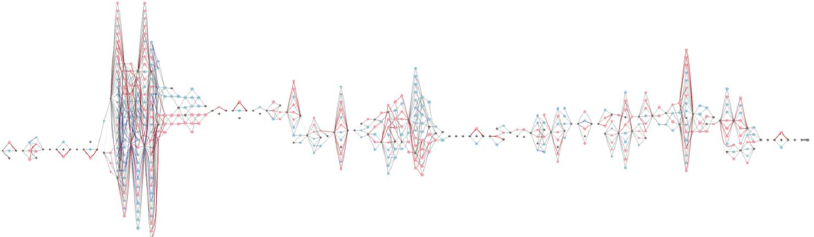
Figure 10. The simplified model from the collected manufacturing log with the statistical analysis.